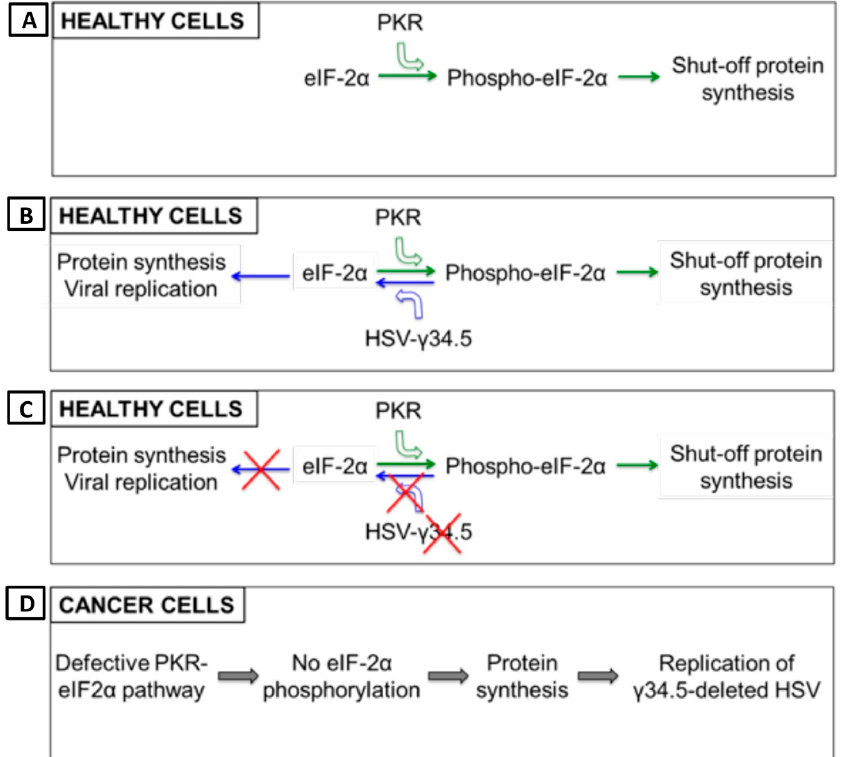
Figure 4. γ -34.5 deletion enhances safety and tumor-specificity of OHSV-IL12. ( A ) Healthy cells have inherent anti-viral defense mechanisms, such as protein kinase R (PKR). PKR phosphorylates translation initiation factor eIF2 α , which shuts down synthesis of foreign proteins or viral antigens. ( B ) OHSV with an intact γ -34.5 overturns anti-viral defense in healthy cells through γ -34.5-mediated dephosphorylation of eIF2 α and helps in viral protein synthesis/viral replication in healthy cells, leading to development of disease. ( C ) γ -34.5 deletion results in no eIF2 α dephosphorylation in normal or healthy cells, and thereby, no protein synthesis and viral replication. ( D ) Cancer cells usually have defective PKR-eIF2 α pathway, thus no inhibition of foreign protein synthesis. Therefore, γ -34.5-deleted OHSV can freely replicate in cancer cells.